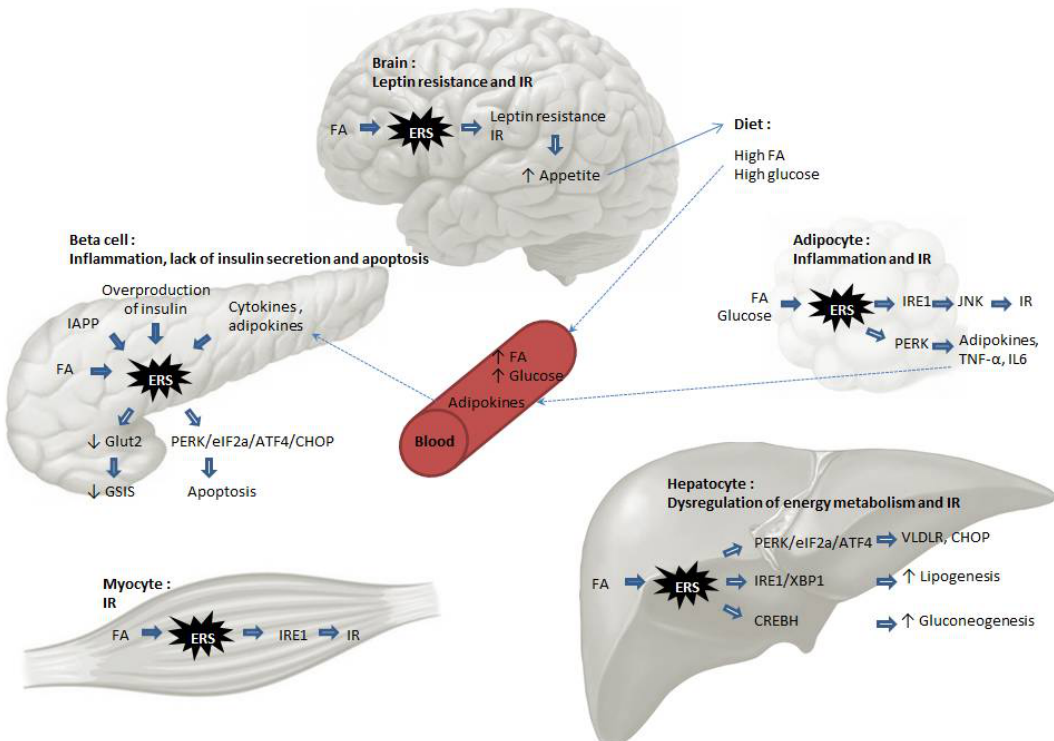
Figure 4. ER stress and the UPR in insulin resistance and diabetes. Insulin resistance and diabetes involve dysregulations in multiple organs, and ER stress participates to all these dysregulations. Excessive dietary FA and glucose induce ER stress in the brain, beta cells of Langerhans islets, myocytes, hepatocytes, and adipocytes. In the brain, this triggers insulin resistance and leptin resistance, with the latter enhancing appetite and thus excessive nutrient intake. In hepatocytes, FA-induced ER stress induces the three branches of the UPR. The PERK arm induces VLDLR and CHOP; the IRE1 arm increases lipogenesis and the CREBH arm enhances neoglucogenesis. In myocytes, this induces the IRE1 arm of the UPR, which deregulates the insulin receptor signaling and thus leads to insulin resistance. In adipocytes, FA and glucose trigger the IRE1 and PERK pathways, which induce, respectively, insulin resistance via JNK induction, and adipokines, TNFα, and IL-6 secretion. These adipokines and cytokines are released into the bloodstream and trigger ER stress in beta cells. FA, IAPP, and insulin overproduction are other triggers of ER stress in this cell type. Consequences of ER stress in beta cell are apoptosis through the PERK/eIF2α/ATF4/CHOP pathway and decreased GSIS via GLUT2 repression. Abbreviations: ERS, ER stress; GSIS, Glucose-Stimulated Insulin Secretion; IR, Insulin Resistance.